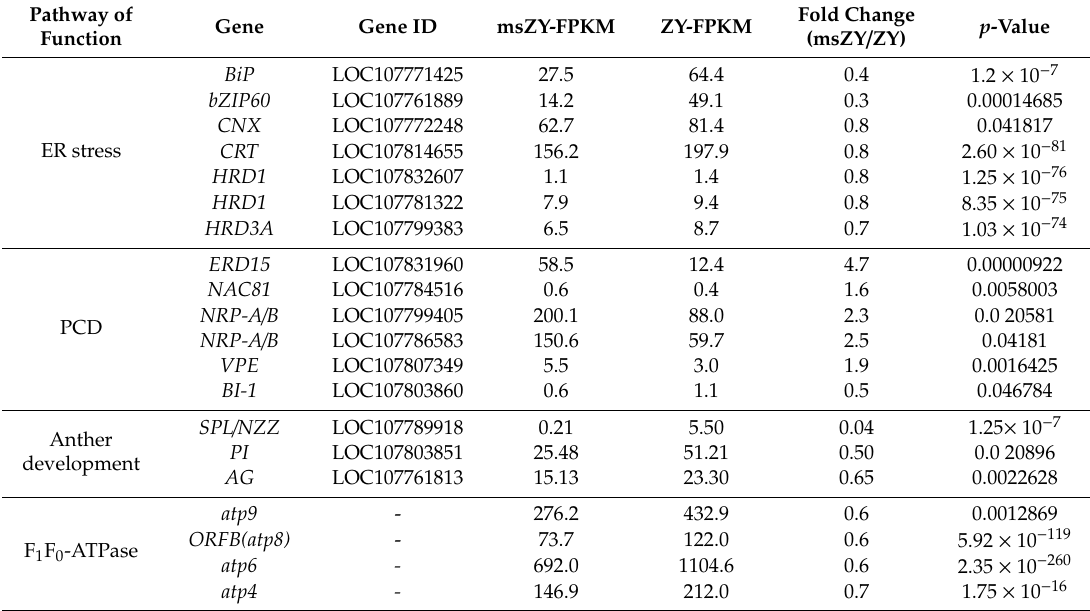
Table 1. DEGs related to endoplasmic reticulum(ER) stress, programmed cell death(PCD), anther development, and F1F0-ATPase.